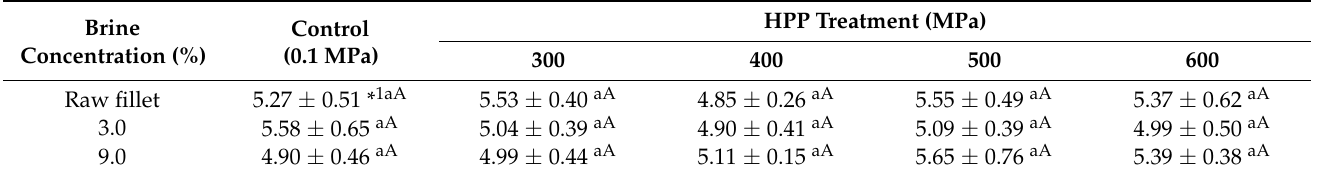
Table 5. The total volatile basic nitrogen (mg/100 g) of mackerel fillets after the brine salting of 3.0% and 9.0% for 90 min at 4 ◦ C and then pressurization at 300, 400, 500, and 600 MPa for 5